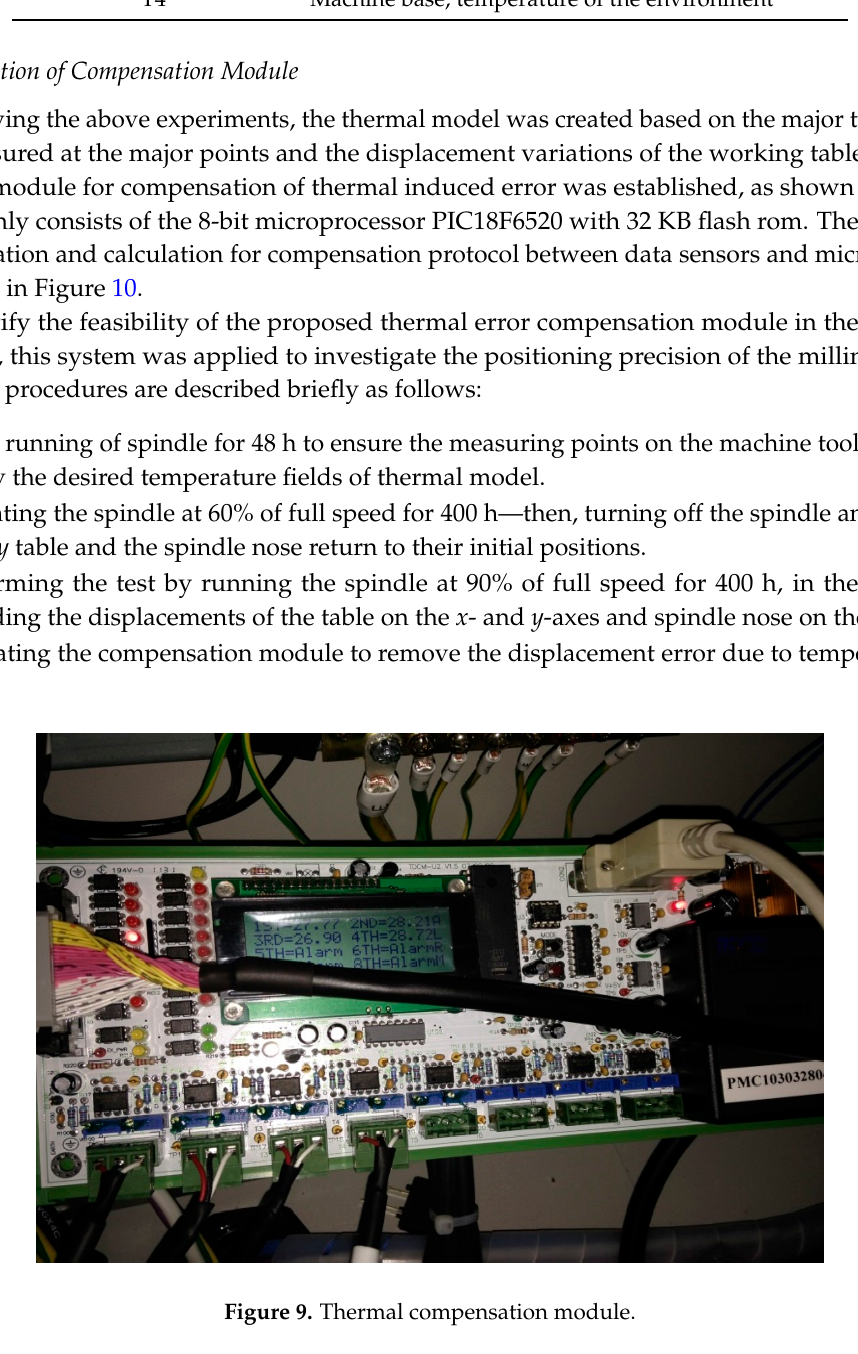
Figure 9. Thermal compensation module.